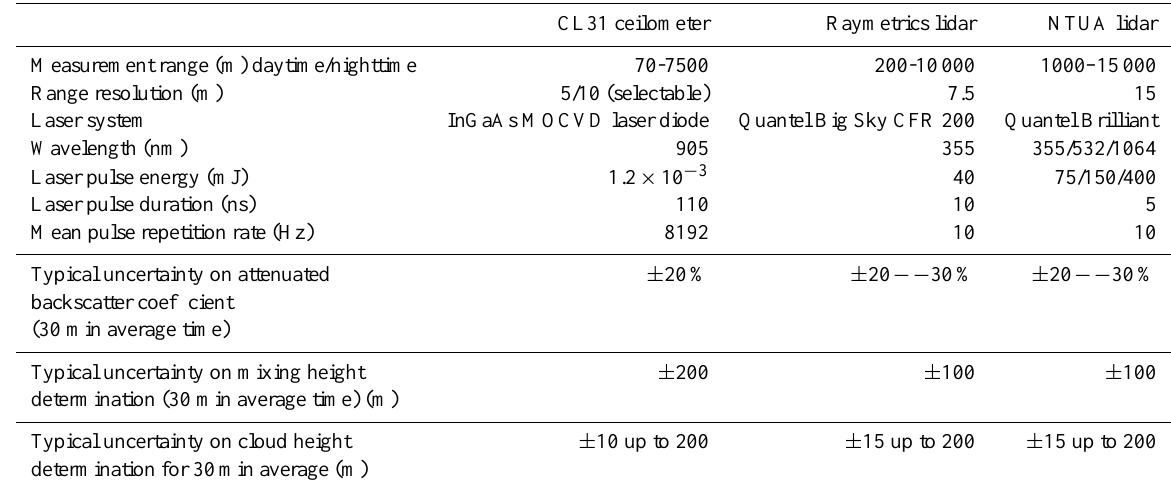
Table 1. Technical properties of the CL31 ceilometer and the Raymetrics and NTUA lidars. Typical uncertainties on the retrieved values of the attenuated backscatter coefficient, the mixing and cloud height are also